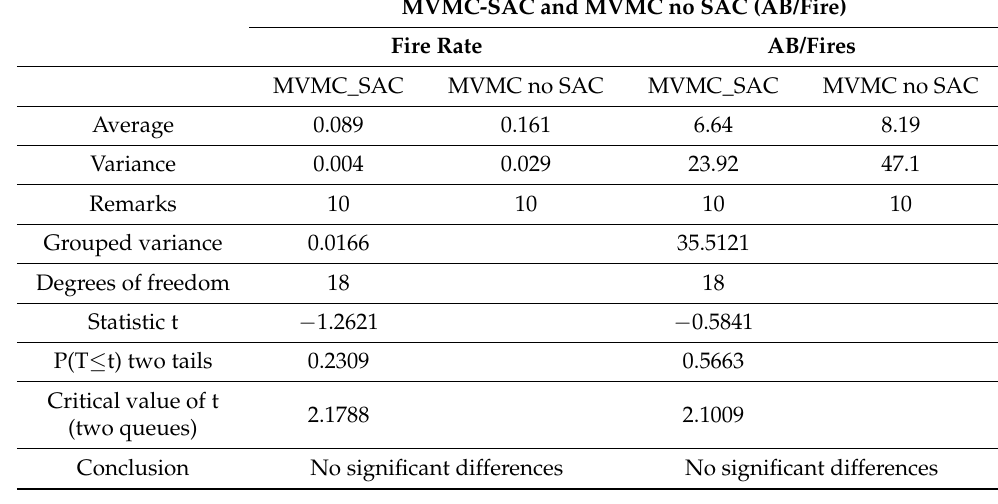
Table 6. Significant differences in the rate of forest fires and in the area burned by fire (BA/wildfire) in MVMC-SAC and MVMC no SAC after 2004.